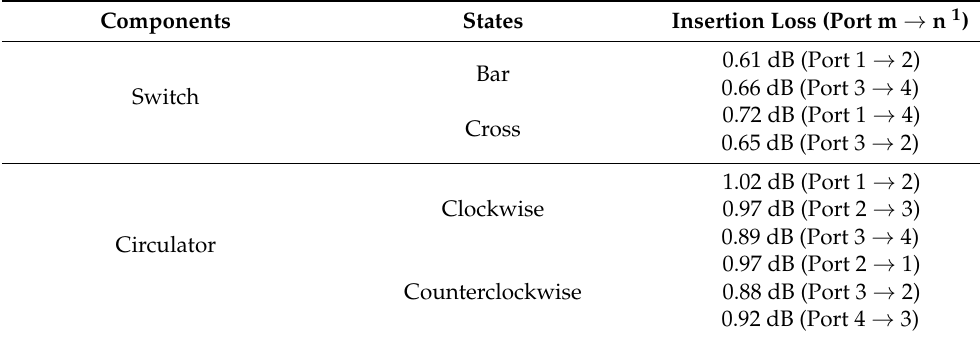
Table 2. Insertion loss of key components in ROA 3 .